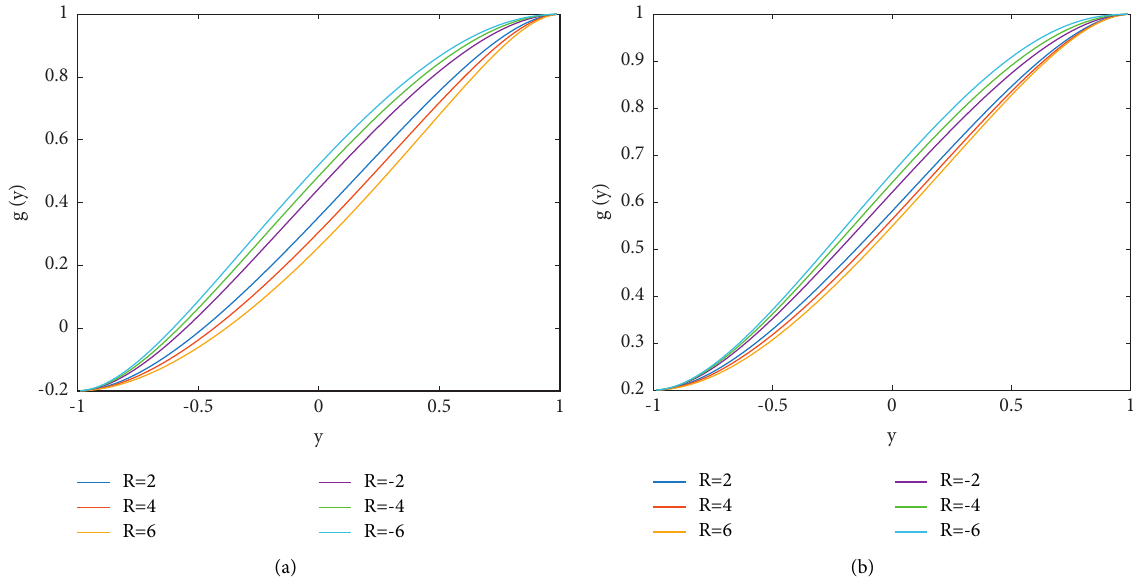
Figure 5: Effect of Reynolds number R over the profile g ( y ) via S2HWs for the parameters (a) A ∗ � − 0 . 2 , α � − 2 , φ � 0 . 1 and (b) A ∗ � 0 . 2 , α � − 2 , φ � 0 .